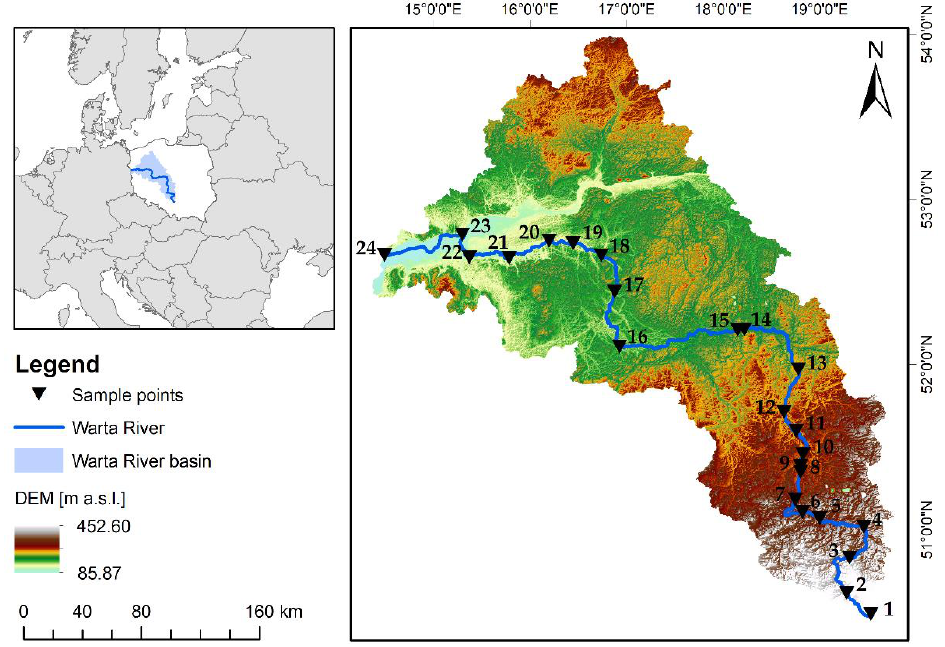
Figure 1. Study site